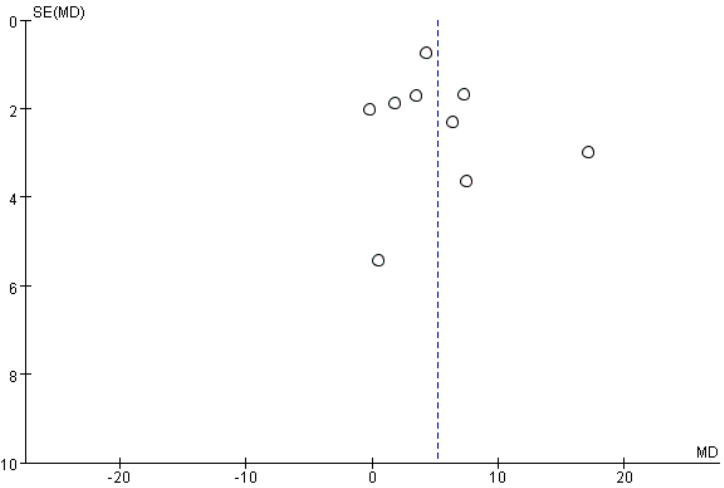
Figure 9. Funnel plot for BBS from the included studies.